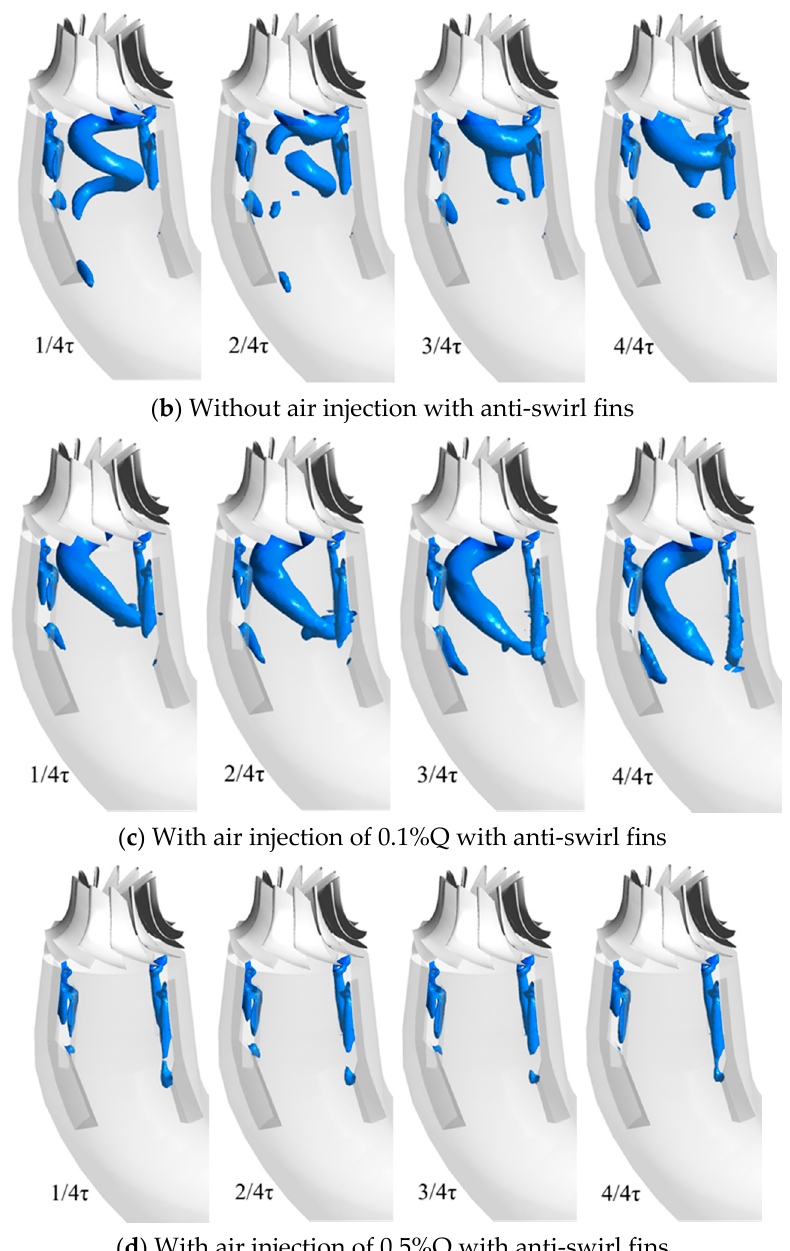
Figure 7. Iso-surface distributions of pressure in the DT during one runner revolution with and without air injection and anti-swirl fins.